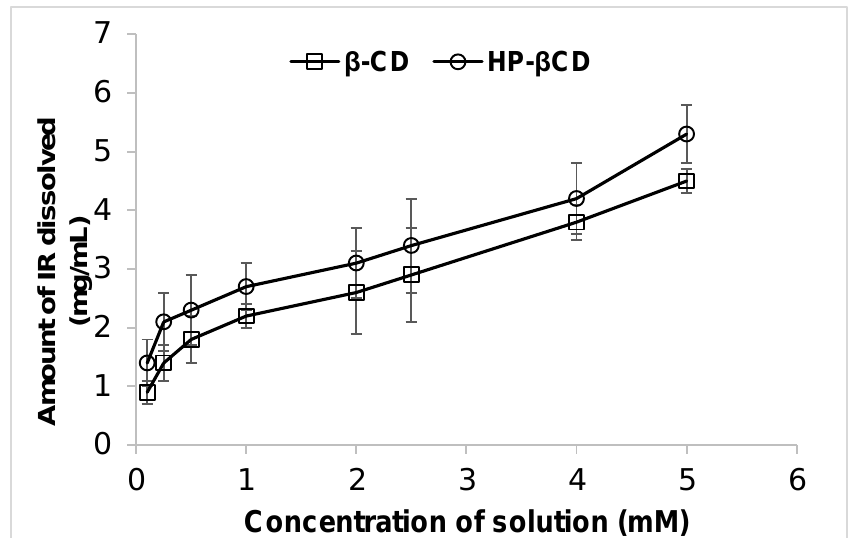
Figure 1. Phase solubility diagram of IR–βCD and IR-HP-βCD inclusion complex in water at 25 ± 2 °C (mean ± SD, n = 4) .